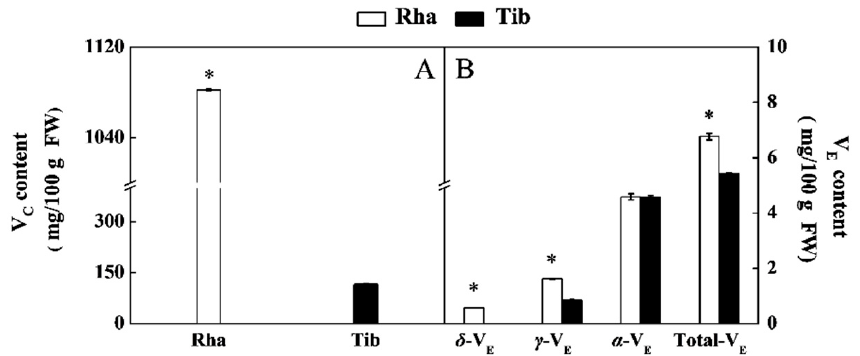
Figure 4. The content of V C ( A ) and V E ( B ) in Rha and Tib berries. Vertical bars represent standard error of the mean ( ± SE), and the “*” indicate significant differences at p < 0.05. ( A ) The content of V C in Rha and Tib berries; ( B ) The content of V E in Rha and Tib